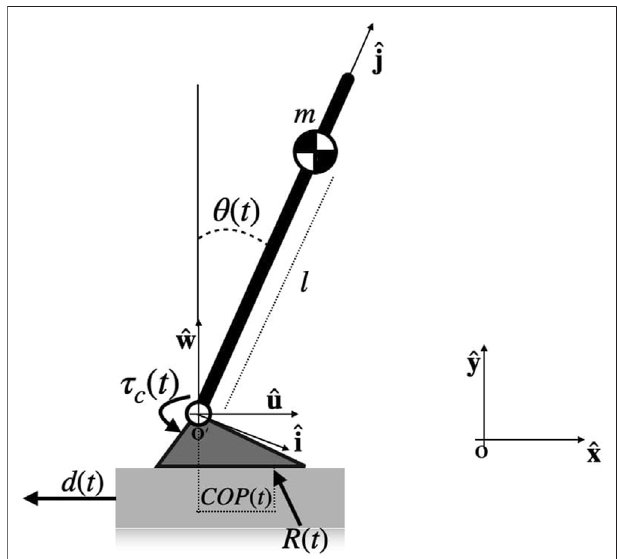
FIGURE1| Biomechanicalmodel oftheuprightstance. Thegeneralized coordinates and the reference frames are also reported, together with the external forces acting on the system and the internal control torque, modeled as a lumped control action acting at the